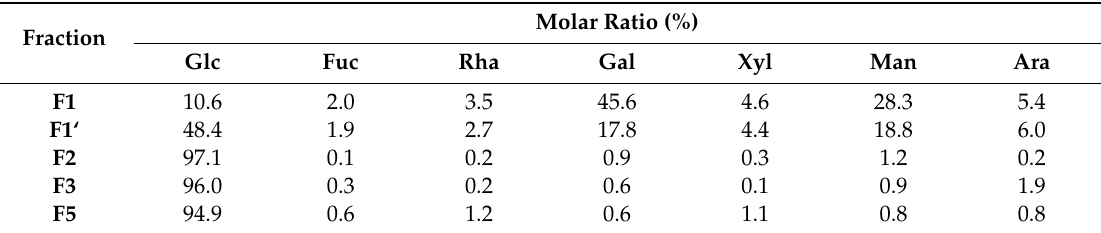
Table 4. Molar ratio (%) of monosaccharides in the polysaccharidic